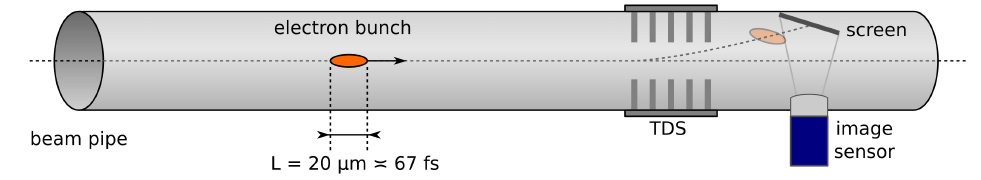
Figure 1. An electron bunch propagating through a beam pipe with a TDS (not to